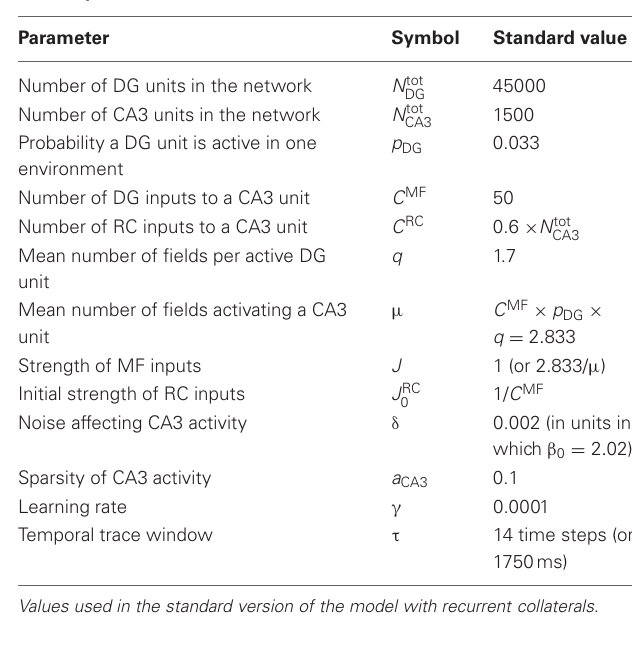
Table 1 | Parameters.